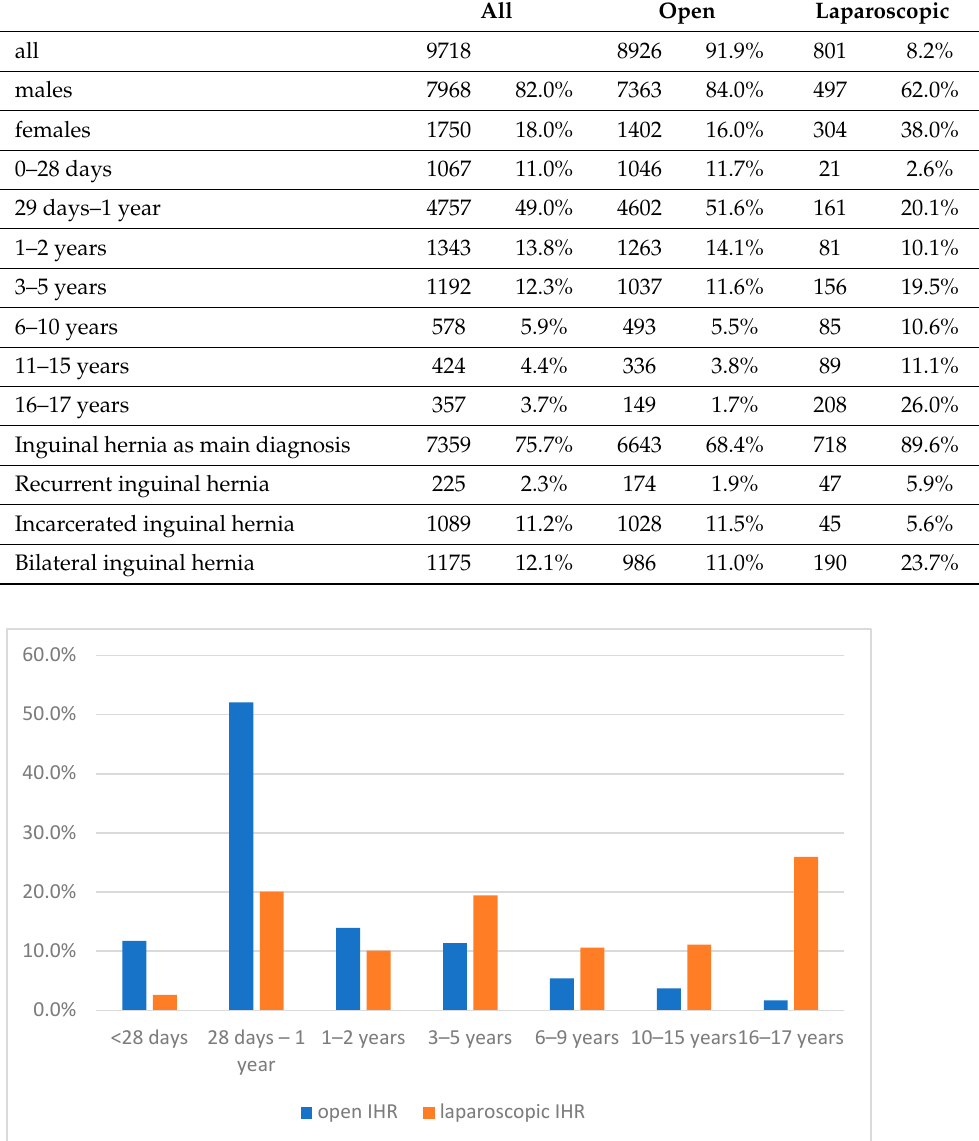
Table 2. Age, gender and diagnoses of children with open and laparoscopic inguinal hernia repair. All Open Laparoscopic all